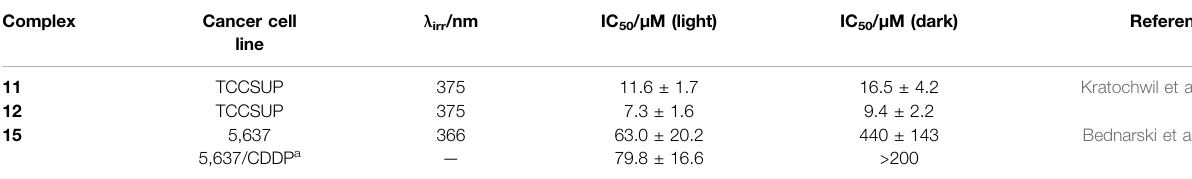
TABLE 2 | IC 50 values of complexes 11 , 12 , and 15 toward different cell lines under light irradiation or dark condition. Complex